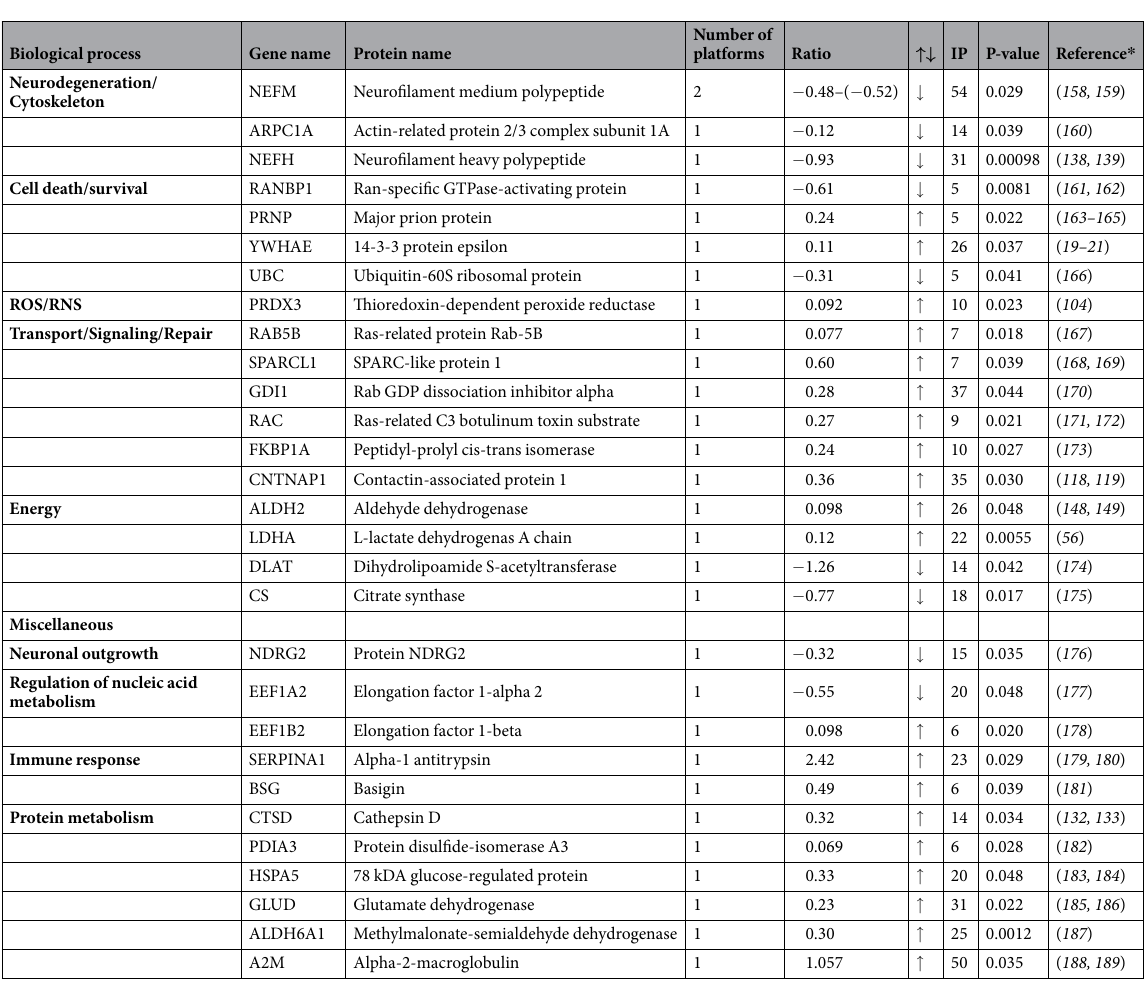
Table 6. Mass spectrometry analysis of brain tissue biopsies from structurally normal-appearing frontal cortex- STUDY B . Significantly up- or downregulated proteins in biopsies from patients with focal traumatic brain injury (TBI) in comparison to idiopathic normal pressure hydrocephalus (iNPH). IP = Number of identified peptides, ↑↓ = Increased or decreased, * = Reference provided in supplementary